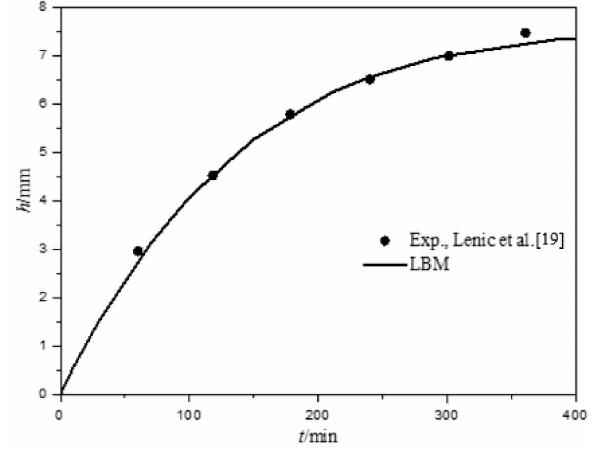
Figure 3. Comparison between simulation results and experimental data